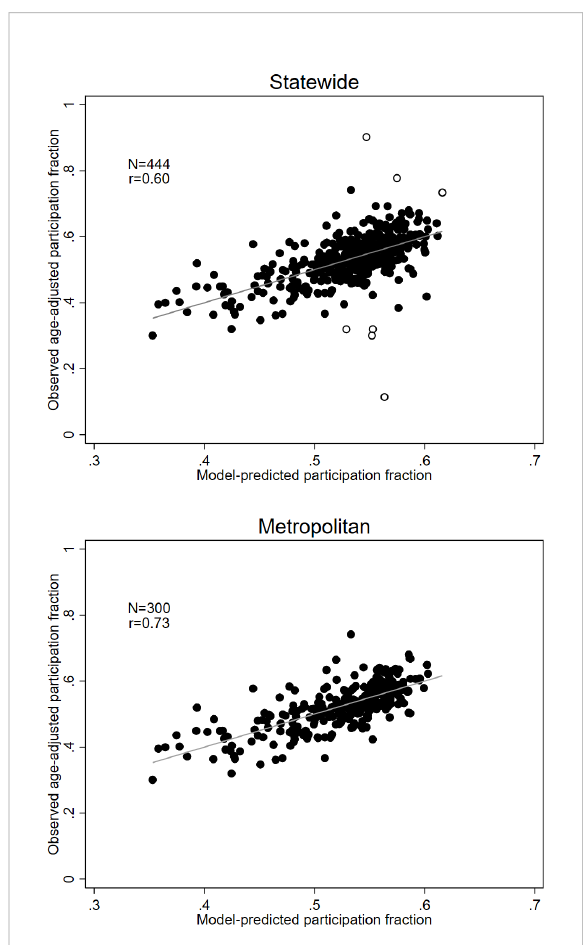
FIGURE 1 Relationship between observed screening participation and those predicted from a regression model using all nine socio- economic and ethnocultural measures, for the entire state (top panel) and metropolitan areas only (bottom panel). Identi fi ed outliers (top panel) are represented by open